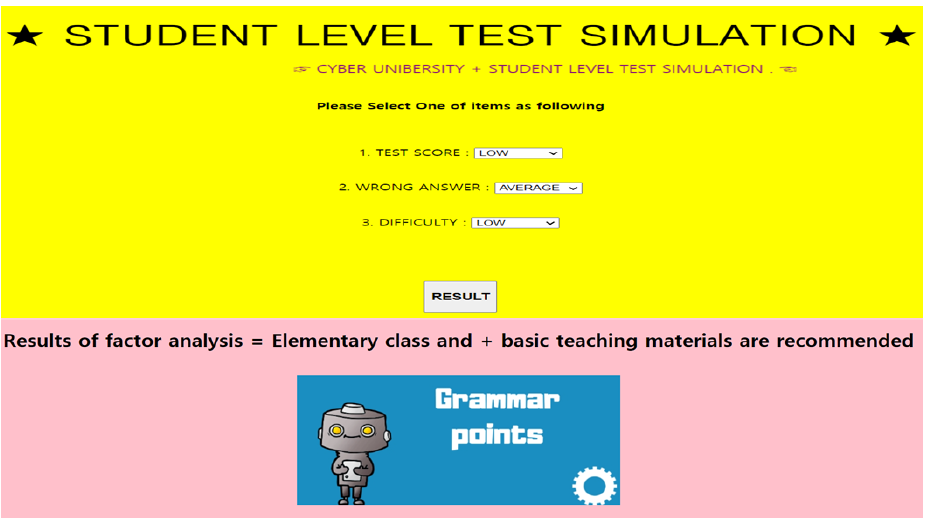
Figure 10. Level test and automatic textbook recommendation.